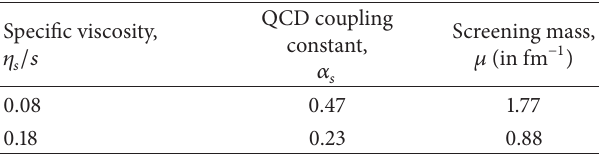
QCD coupling Screening mass, constant, 𝜇 (in fm −1 ) 𝛼 𝑠